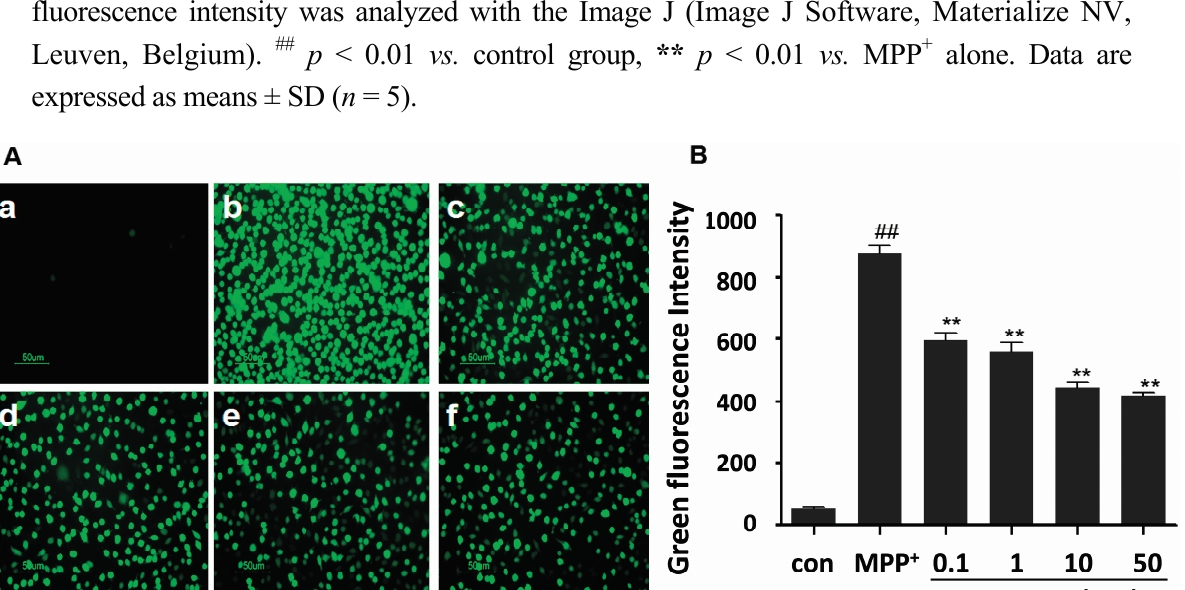
Figure 2. CsV suppressed MPP + -induced ROS accumulation in SH-SY5Y cells. ( A )